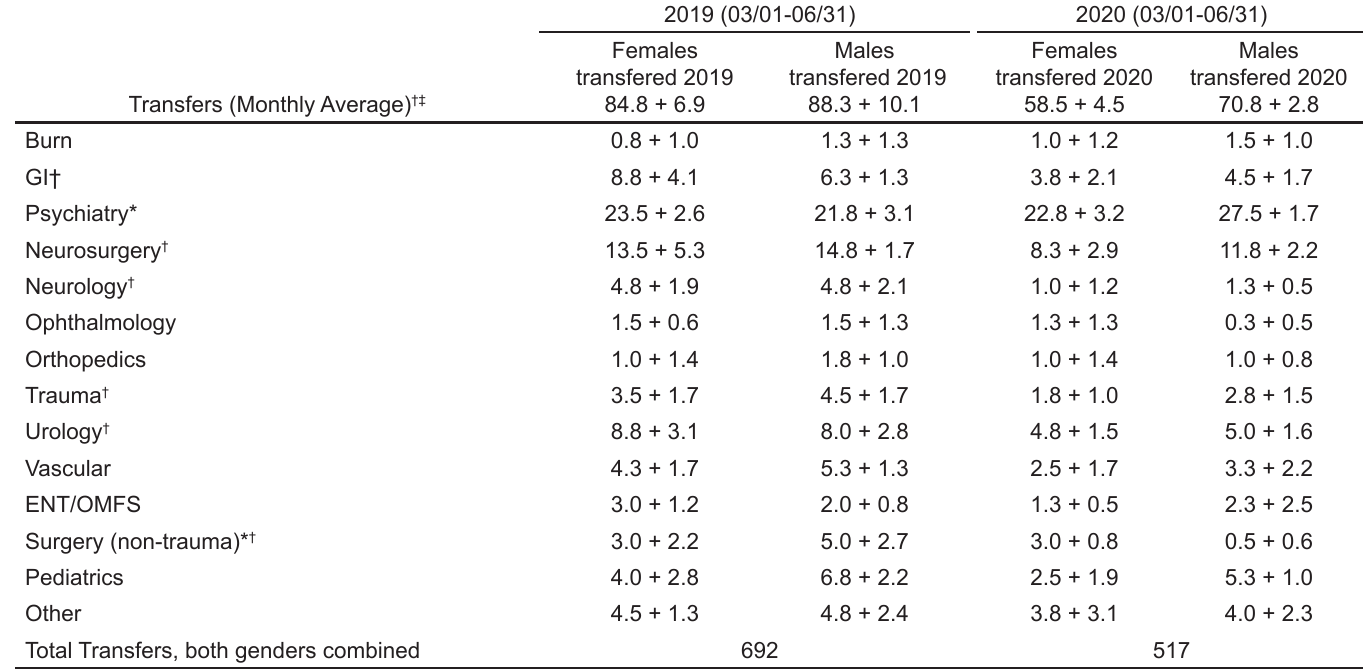
Table. Average monthly transfers before and during the COVID-19 pandemic. Data shows the average monthly transfer counts + one standard